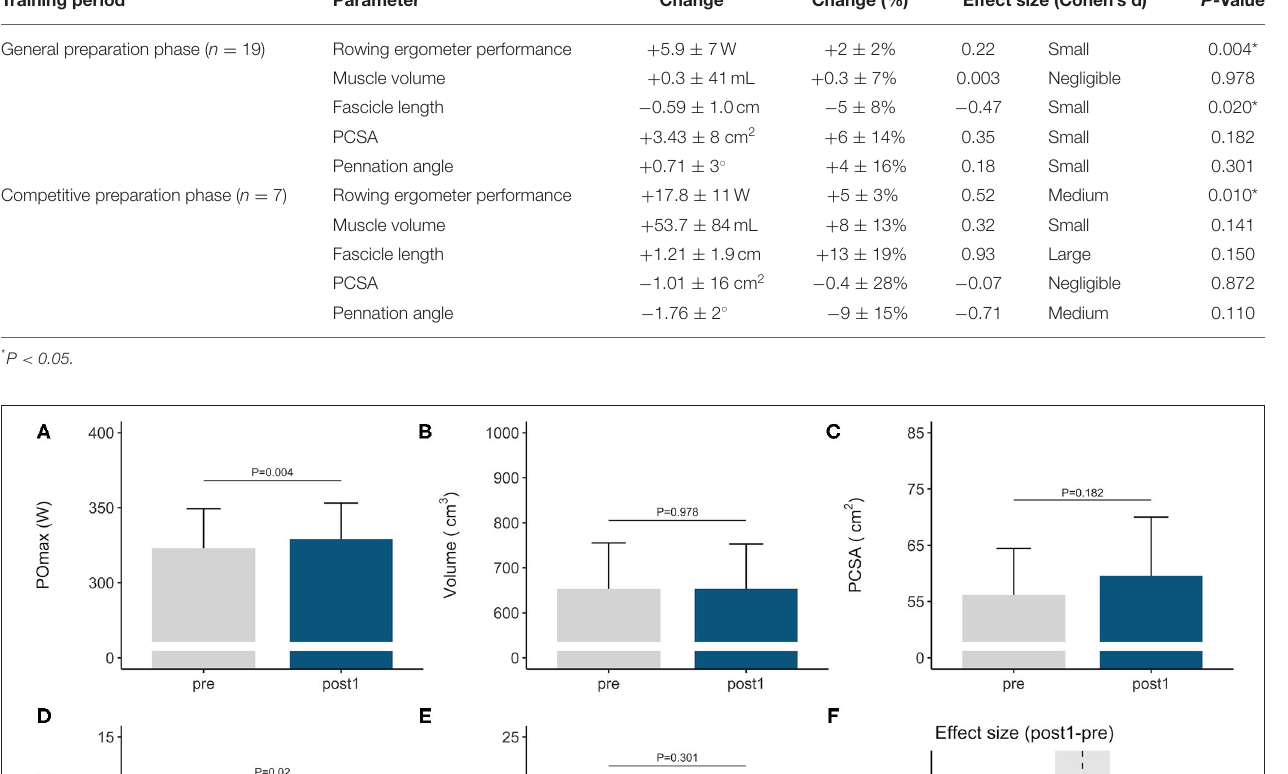
TABLE 2 | Functional and morphological adaptations following the general preparation phase and competitive preparation phase in elite female rowers. Training period